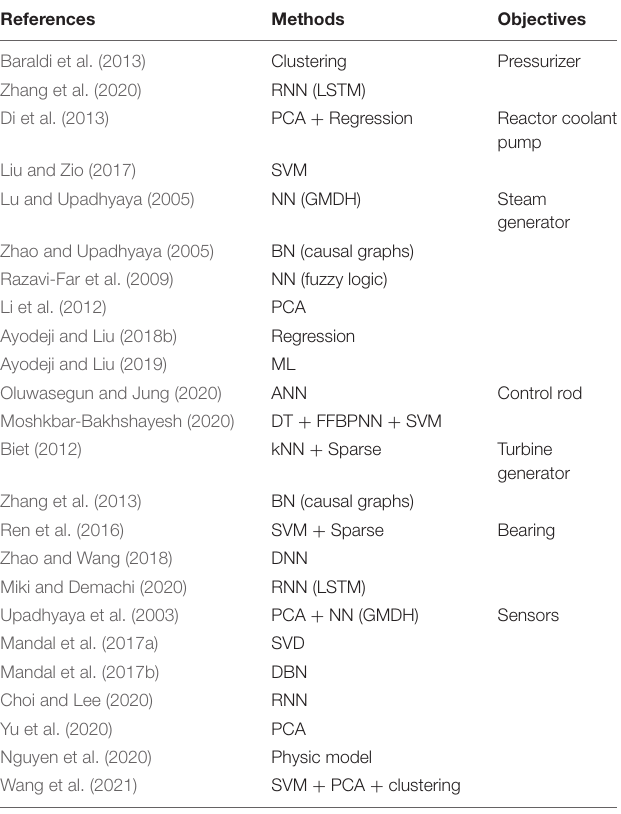
TABLE 5 | Latest applications of the data-driven machine learning (DDML) for the fault diagnosis and detection (FDD) of the nuclear power plant (NPP) component.